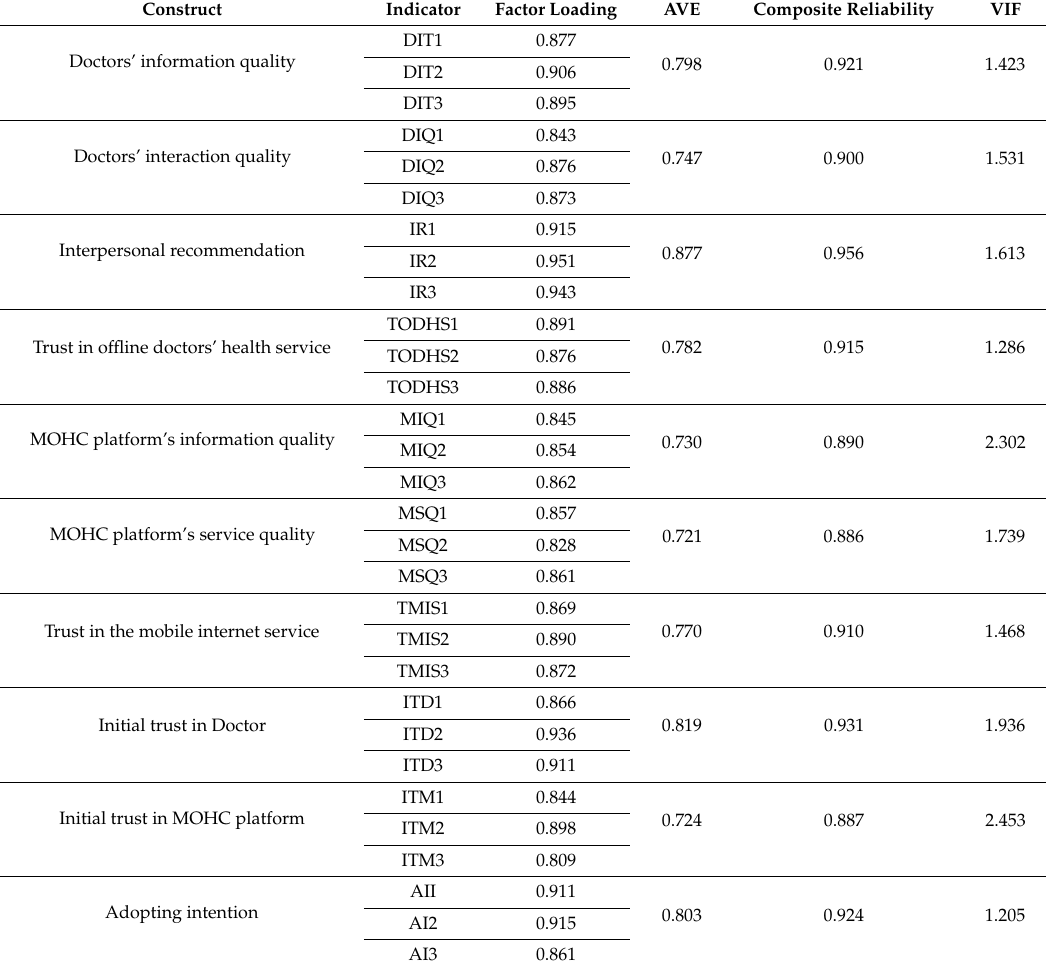
Table 3. Item loadings, AVE, CR, and VIF